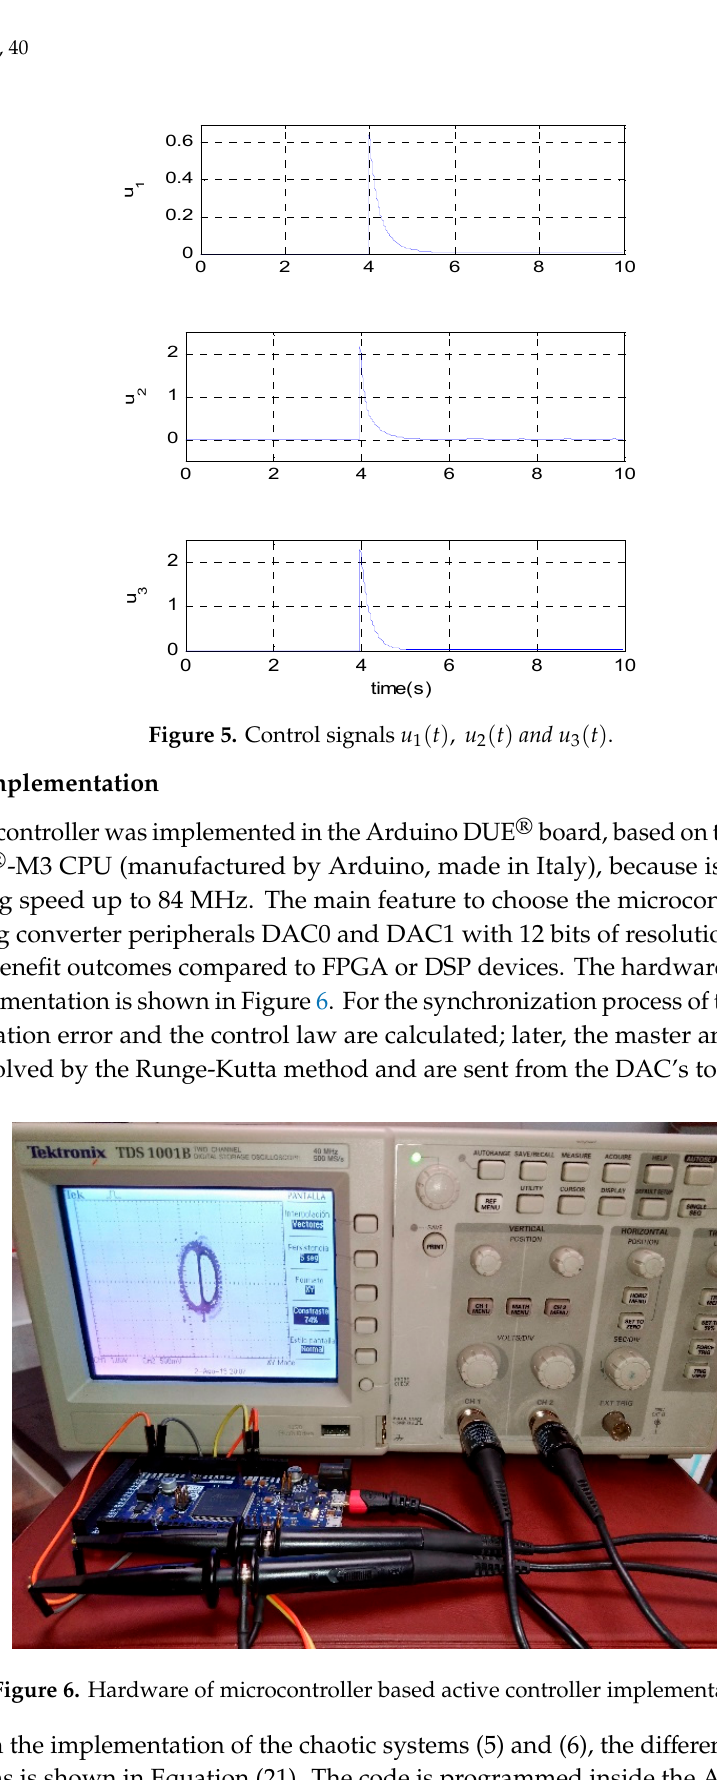
Figure 4. Time evolution of synchronization error signals by numerical simulation